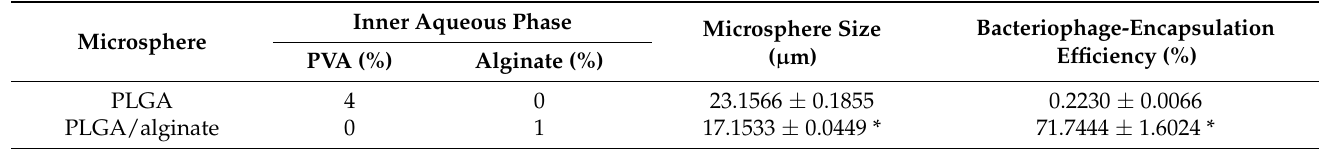
Table 1. Physical characteristics of bacteriophage-loaded microsphere. Values are the means ± standard error of triple replicates.